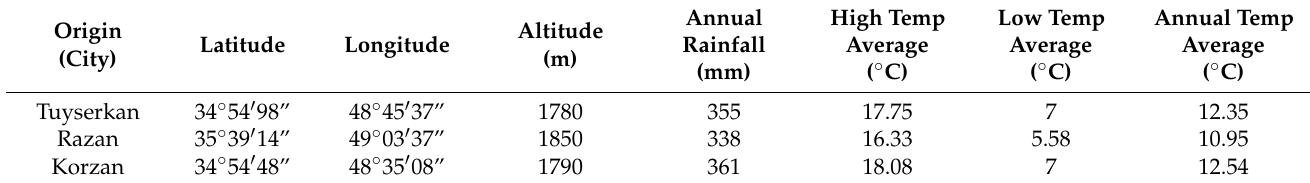
Figure 1. Map of walnut germplasm evaluation locales in Hamedan, Iran, and superior genotypes in this research. Table 1. Environmental conditions for the regions of Hamedan Province where walnut genotypes were selected for the study.